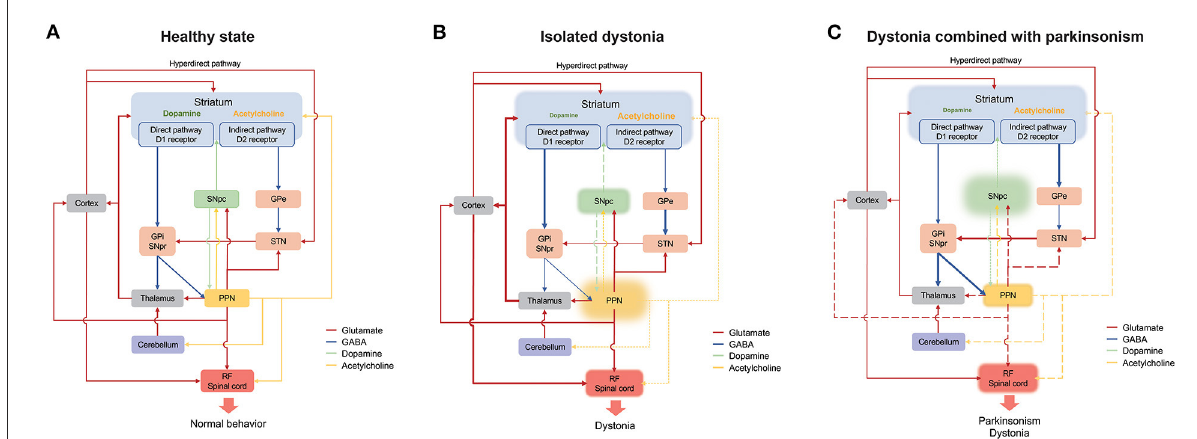
FIGURE1 Schematic representation of the connection of the PPN in the basal ganglia-cerebello-thalamo-cortical circuit under normal (A) , isolated dystonia (B) , and dystonia combined with parkinsonism (C) . Thickened and thinned lines represent enhanced and decreased activity, respectively. Dashed lines show primarily loss whereas long dashed lines indicate secondarily loss. Cortico-striatum inputs modulate central selection of competing alternative actions through direct, indirect and hyperdirect pathways. And the inhibitory GABA outputs from GPi and SNpr project to the cortex through the thalamus and eventually participate in motor execution. The PPN has connections with the basal ganglia, the thalamus, cerebellum, and RF/spinal cord, with its cholinergic outputs mainly project to the striatum, the SNpc and the RF/spinal cord. In normal state (A) , adequate motor selection of the basal ganglia and the balance of the dopamine and the acetylcholine result in normal behavior. In isolated dystonia (B) , the PPN is primarily affected, which mainly involves the loss of cholinergic neurons. The cholinergic deficit of the PPN directly influences the neural activity of the striatum and the RF/spinal cord and indirectly affects the dopamine release in the striatum though SNpc, which result in the disturbance of central selection and the presence of dystonia. In dystonia combined with parkinsonism (C) , the dopaminergic system of the SNpc is primarily affected. The deficit of the dopamine release in the striatum results in the overactivity of the indirect pathway, which leads to the presence of parkinsonism. On the other hand, the pathology of the SNpc contributes to the dysfunction of both glutamatergic and cholinergic systems in the PPN, which thereafter directly induces the disinhibition of the RF/spinal cord or indirectly affects the function of the striatum, thalamus and cortex. GABA, γ -aminobutyric acid; GPe, globus pallidus externus; GPi, globus pallidus internus; PPN, pedunculopontine tegmental nucleus; RF, reticular formation; SNpc, substantia nigra pars compact; SNpc, substantia nigra pars reticulata (SNpr); STN, subthalamic